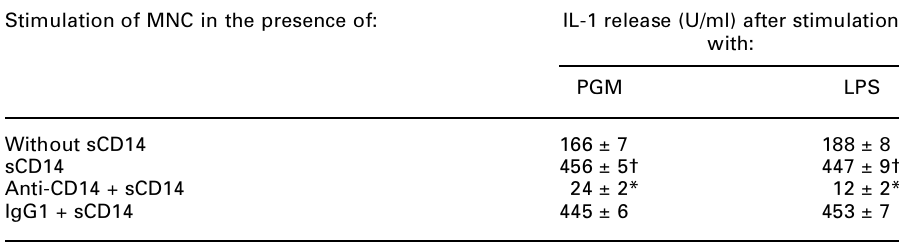
Table 1. The effects of soluble CD14 (sCD14) and anti-CD14 monoclonal antibody (MEM-18) on IL-1 release from human mononuclear cells (MNC) stimulated with peptidoglycan monomer (PGM) or lipopolysaccharide (LPS) Stimulation of MNC in the presence